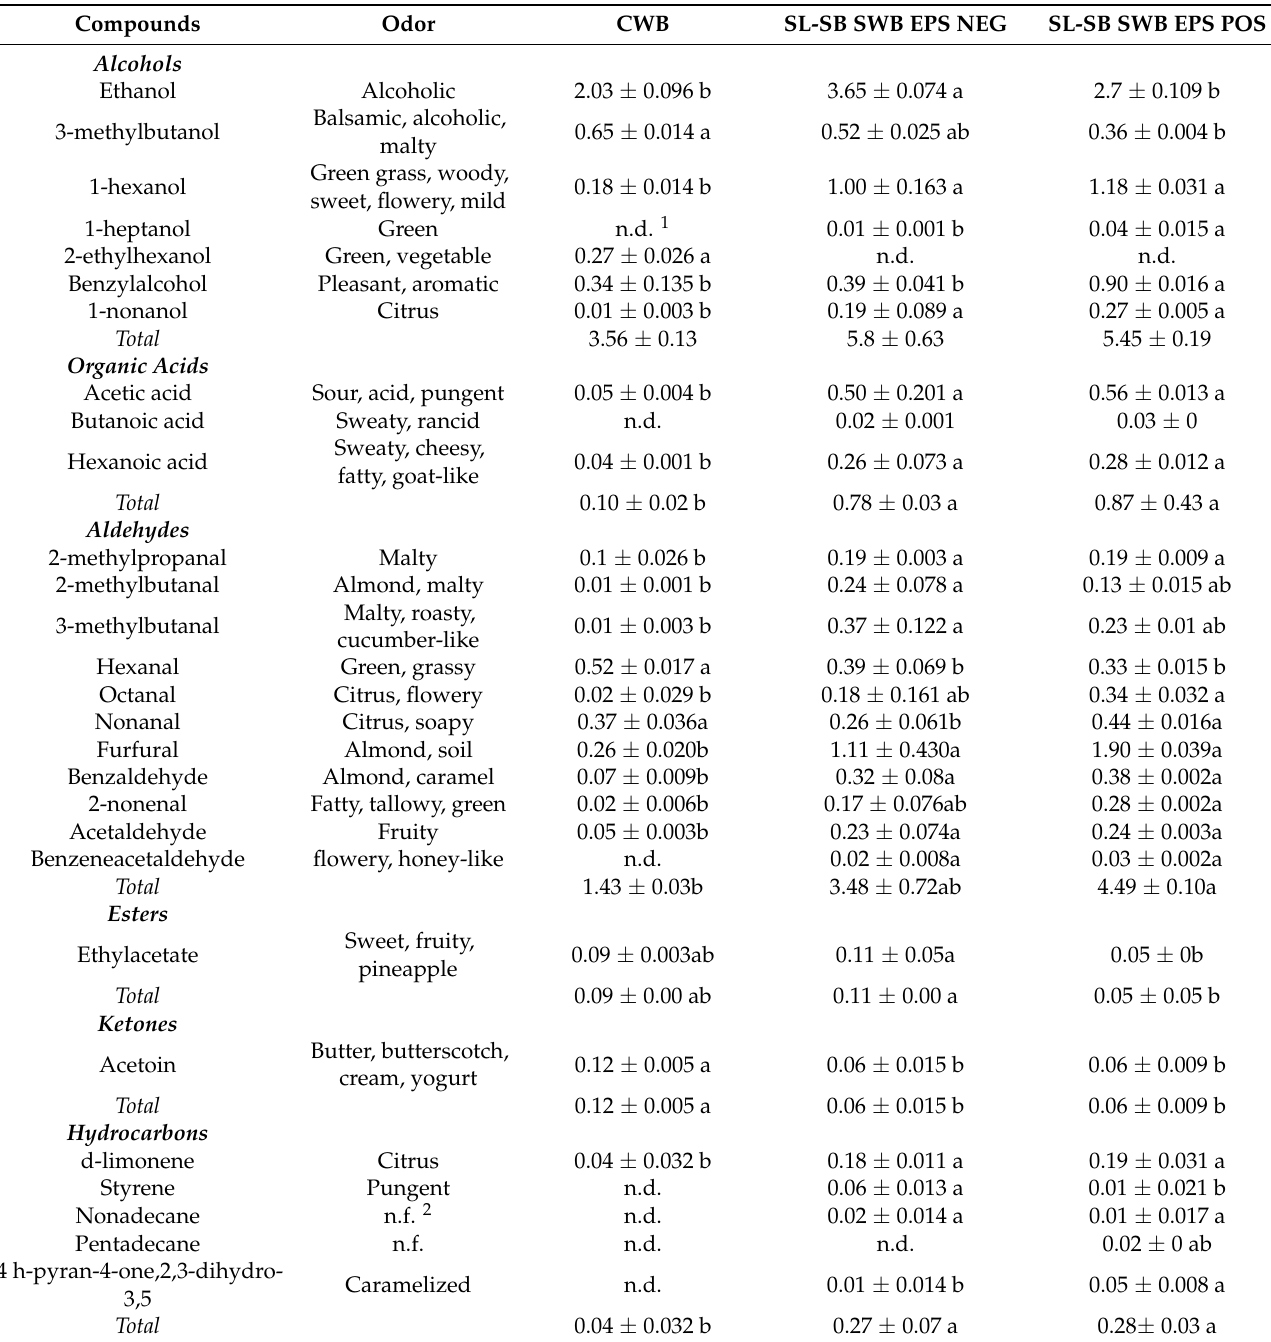
Table 2. Quantification of total volatile organic compounds (VOCs) divided by chemical classes in control and sourdough breads (DY 162). Normalized data with the internal standard are reported, calculated as ratio peak area/total peak area percent. CWB, control wheat bread started with baker’s yeast; SB-SL SWB EPS NEG, bread containing wheat flour added with 30% ( w / w ) sprouted barley–sprouted lentil (30:70%) sourdough fermented by Leuconostoc pseudomesenteroides DSM 20193; SB-SL SWB EPS POS, bread containing wheat flour added to 30% ( w / w ) dextran-containing sprouted barley–sprouted lentil (30:70%, w / w ) sourdough fermented by L. pseudomesenteroides DSM 20193. The initial cell density of the strain